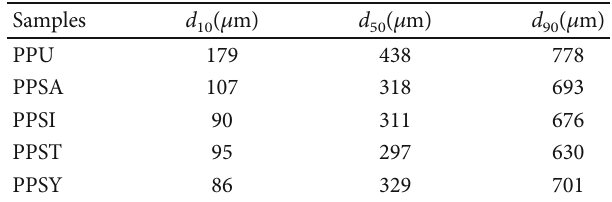
Table 2: The particle size distribution of PPAs.